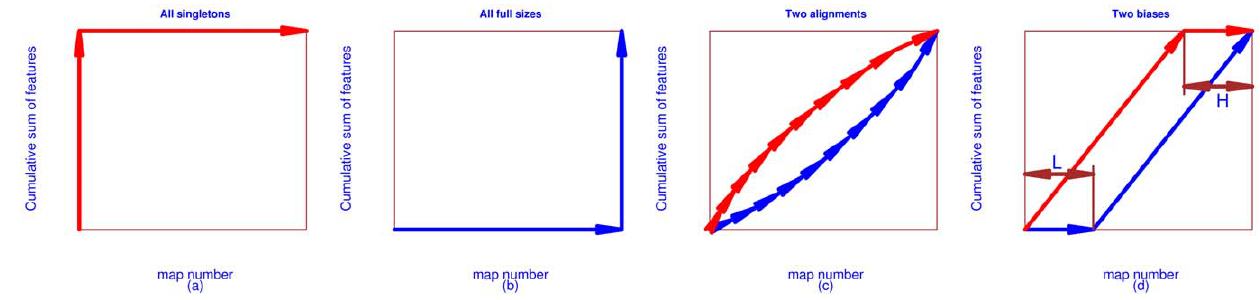
Figure 11. Two extreme and common examples of CAM curves. (a) Pattern I (disastrous pattern): all predicted consensuses are singletons; (b) Pattern II (perfect pattern): all predicted consensuses are of full size; (c) Pattern III (normal pattern): the comparison of two CAM curves for two alignments; (d) Pattern IV (biased pattern): two biased alignments. The upper one is defined as the biased H-pattern and the lower one is defined as the biased L-pattern. The horizontal axes represent the number of maps. The vertical axes represent the cumulative sum of features. (a) - panel 1: Pattern I; (b) - panel 2: Pattern II; (c) - panel 3: Pattern III; (d) - panel 4: Pattern IV.